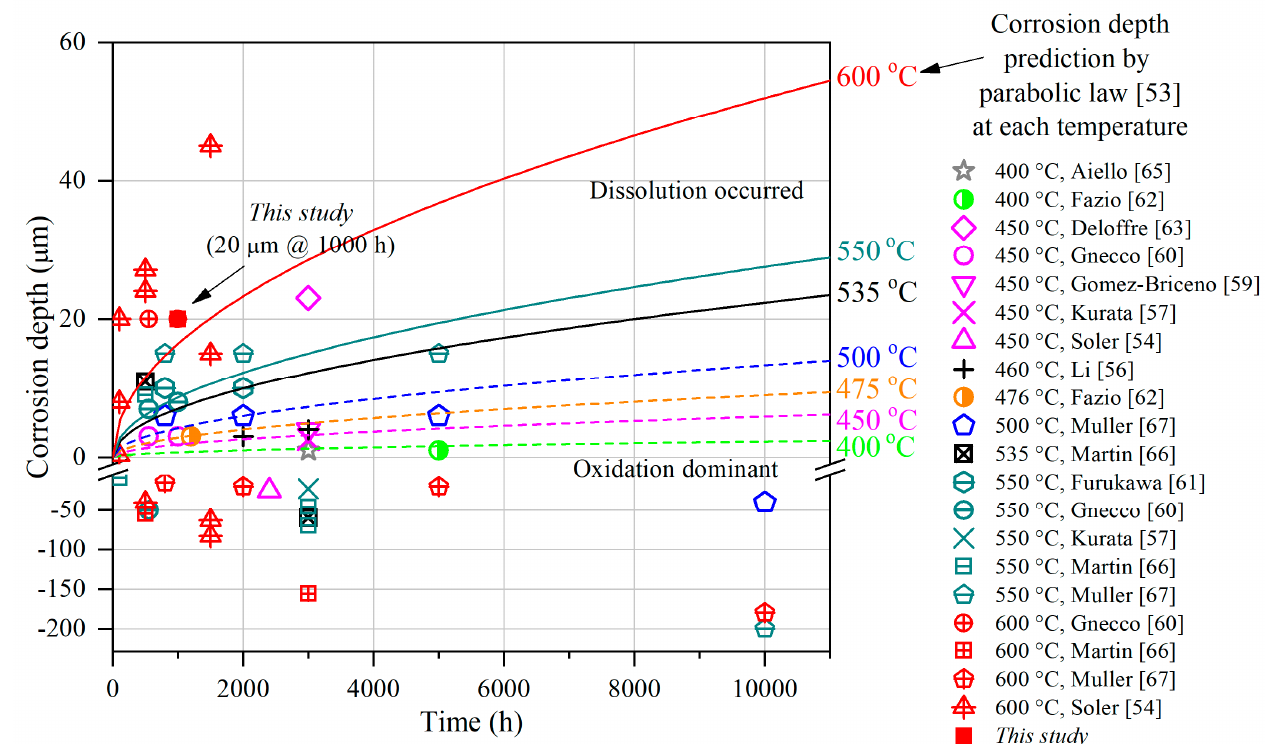
Figure 17. Prediction of the corrosion depths on SS316L [53,54,56,57,59-63,65-67].